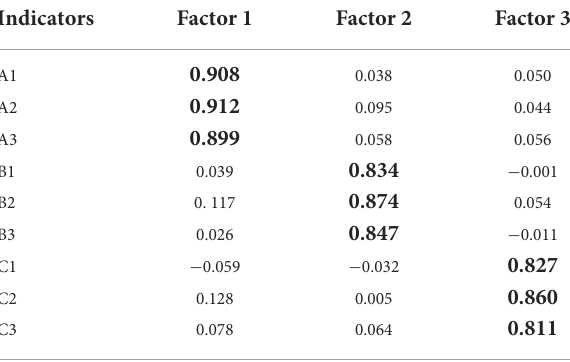
TABLE 1 Exploratory factor analysis of knowledge-sharing